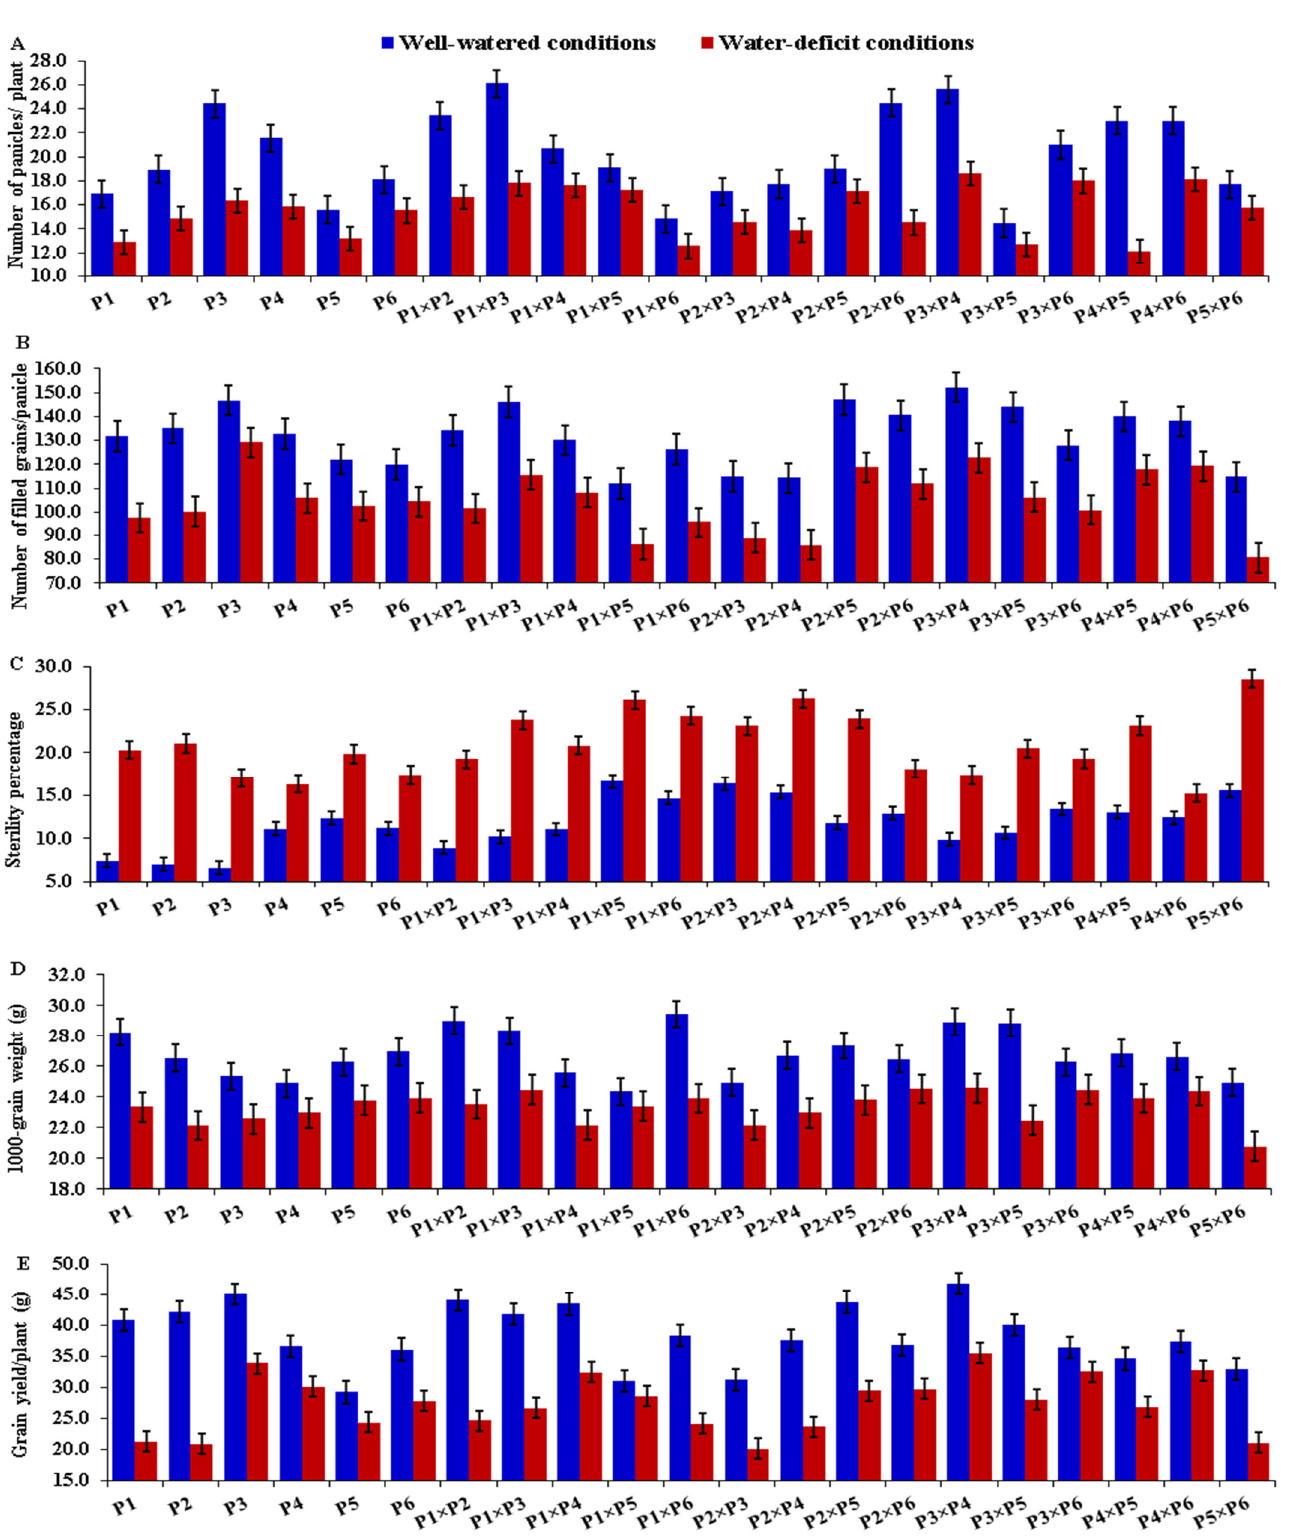
Figure 3. Mean performance of the six rice parents and their 15 F 1 crosses for number of panicles per plant ( A ), number of filled grains per panicle ( B ), sterility % ( C ), 1000-grain weight ( D ), and grain yield per plant ( E ) under well-watered and water-deficit conditions. The bars on the columns represent LSD ( p ≤